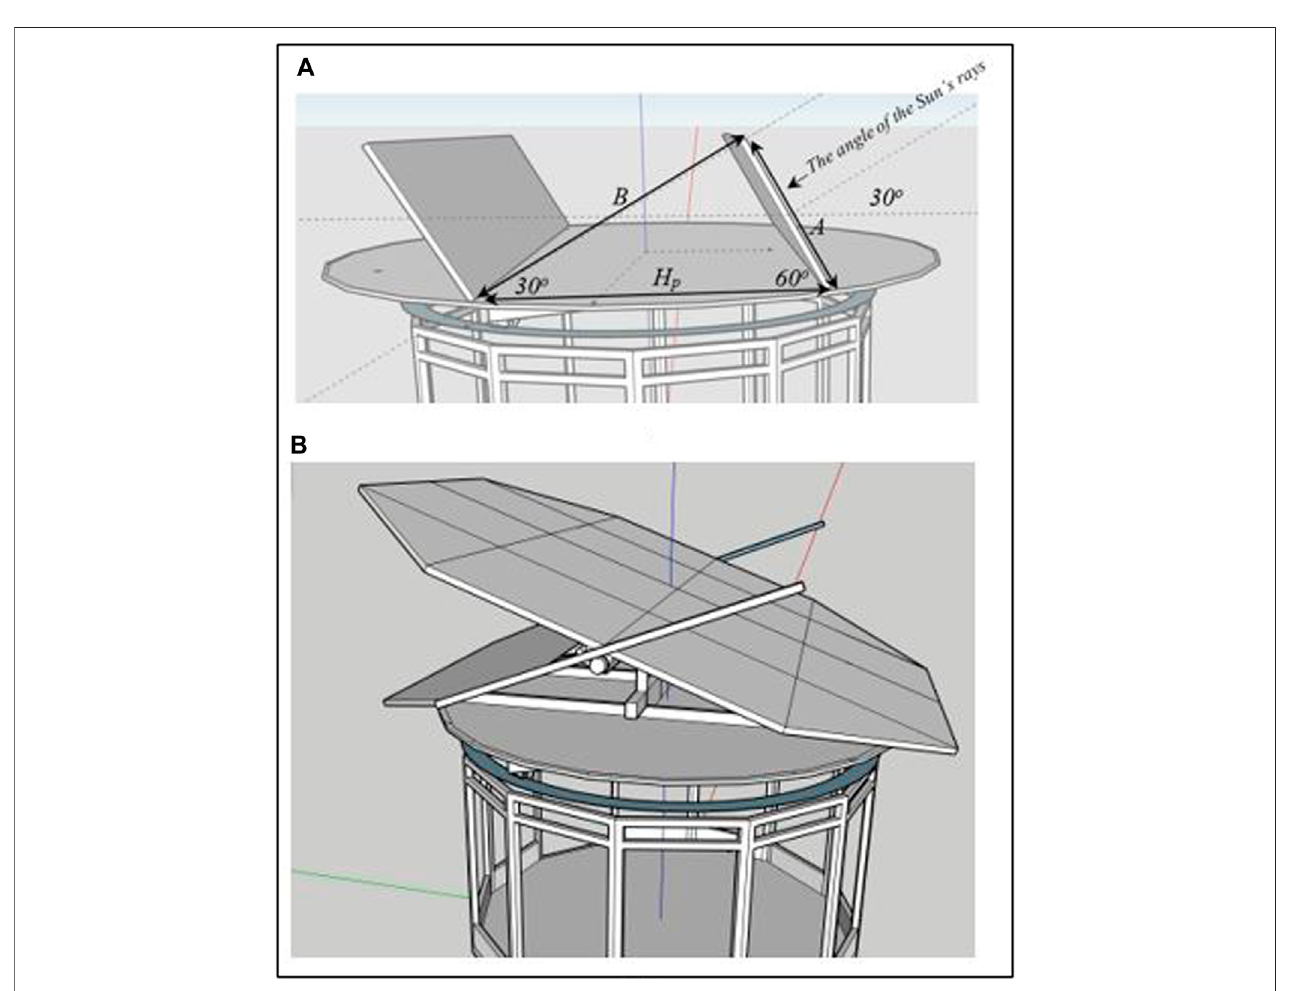
FIGURE 2 | Two different design studies of RRGS. (A) First design with low ef fi ciency. (B) Second design with high ef fi ciency.